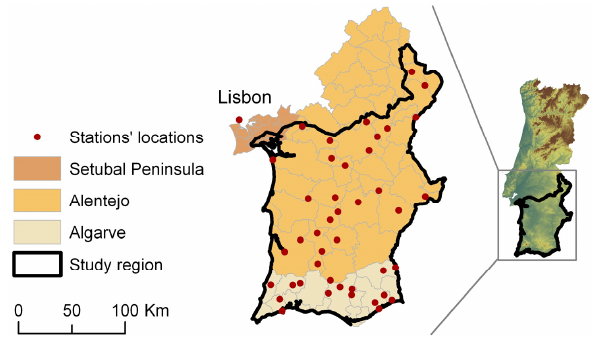
Fig. 1. Study region in the south of Portugal and meteorological stations’ locations.